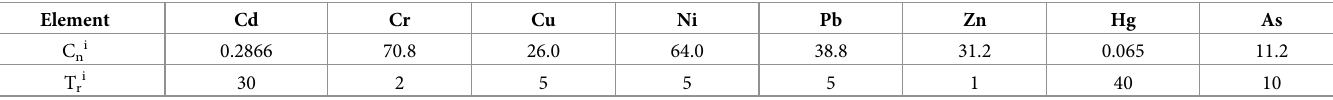
Table 4. The reference ratio (C ni ) and toxicity response parameter (T ri ) of heavy metals in soil. Element Cd Cr Cu As C ni 0.2866 T